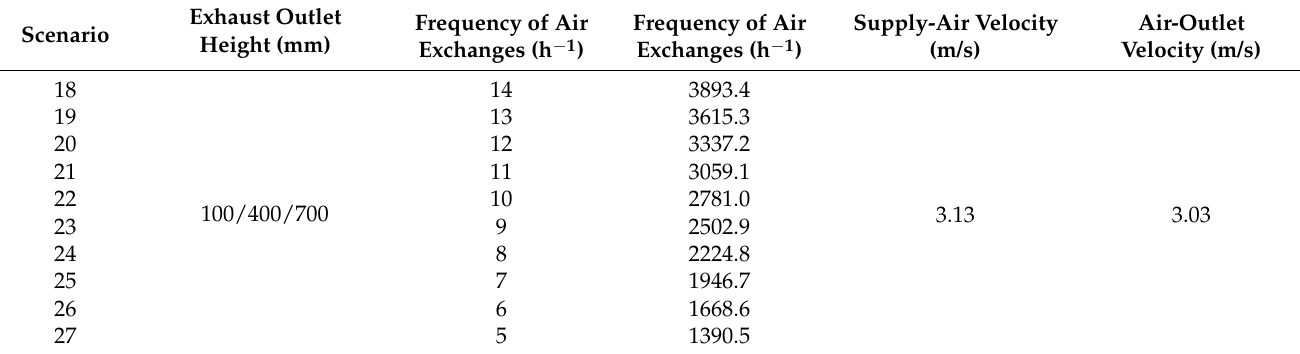
Table 12. Boundary conditions of side exhaust air for different frequencies of air exchanges.